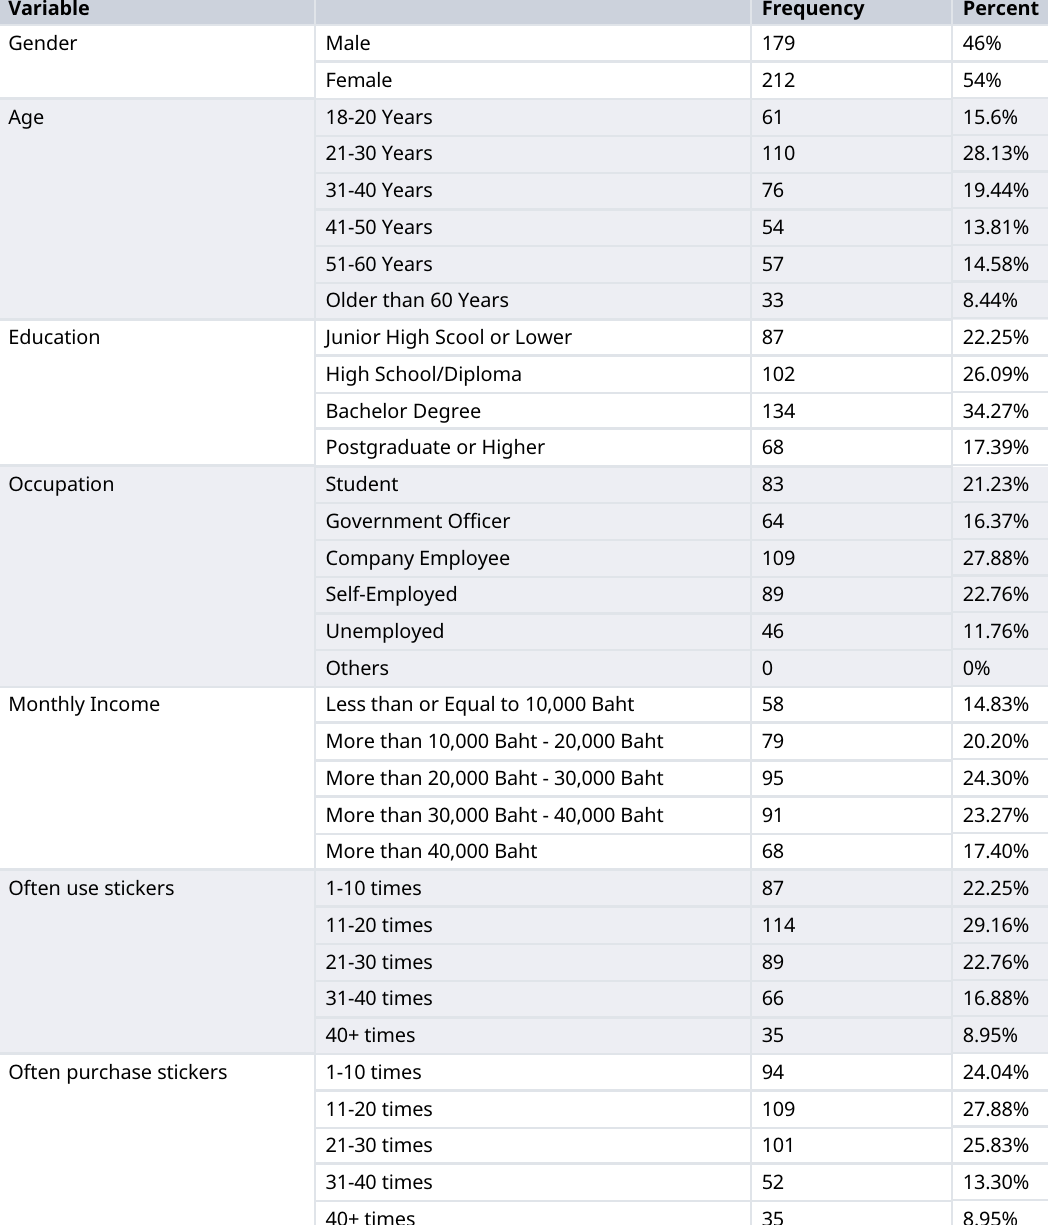
Table 2. Demographic characteristics of the